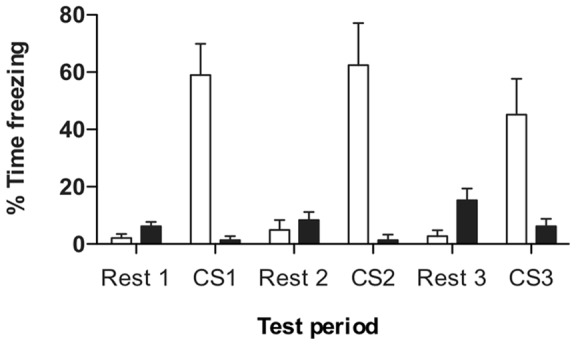
Behavioural response to the fear conditioning paradigm.Animals were trained with paired CS-US presentations (paired group (PG), open bars; n = 6) and unpaired CS and US presentations (unpaired group (UG), black bars; n = 6) and freezing behaviour was assessed 24 h later in a separate context. A two-way ANOVA revealed that PG spent a greater proportion of time freezing than UG animals during all three stimulus presentations (P<0.01). Data is represented as mean ± SEM.